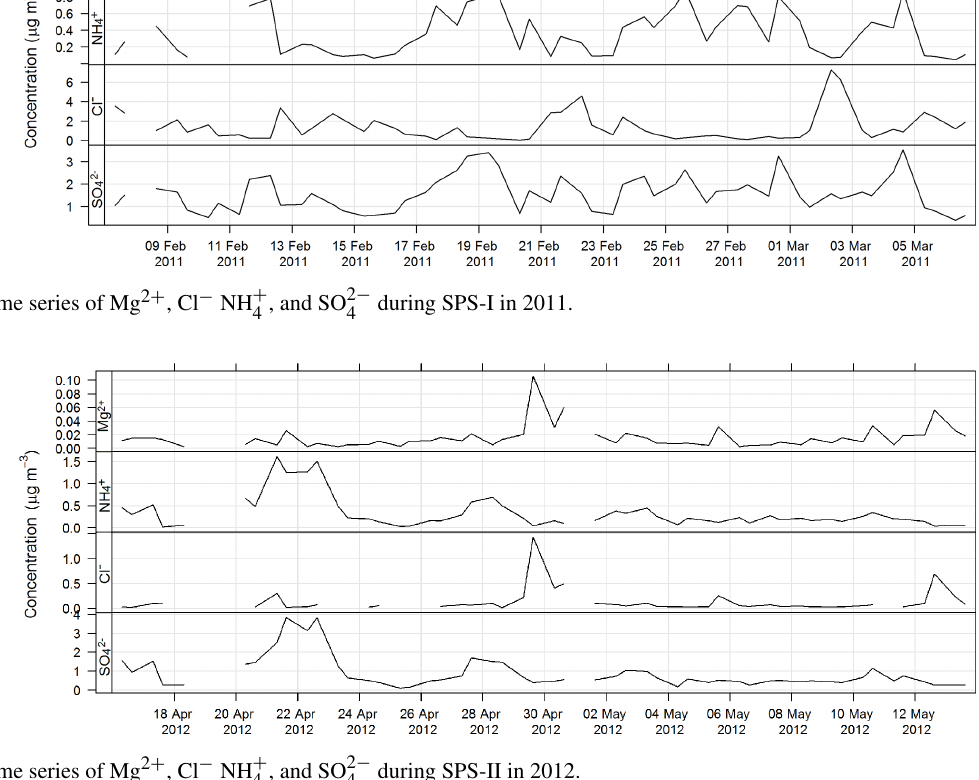
Figure 14. Time series of Mg 2 + , Cl − NH